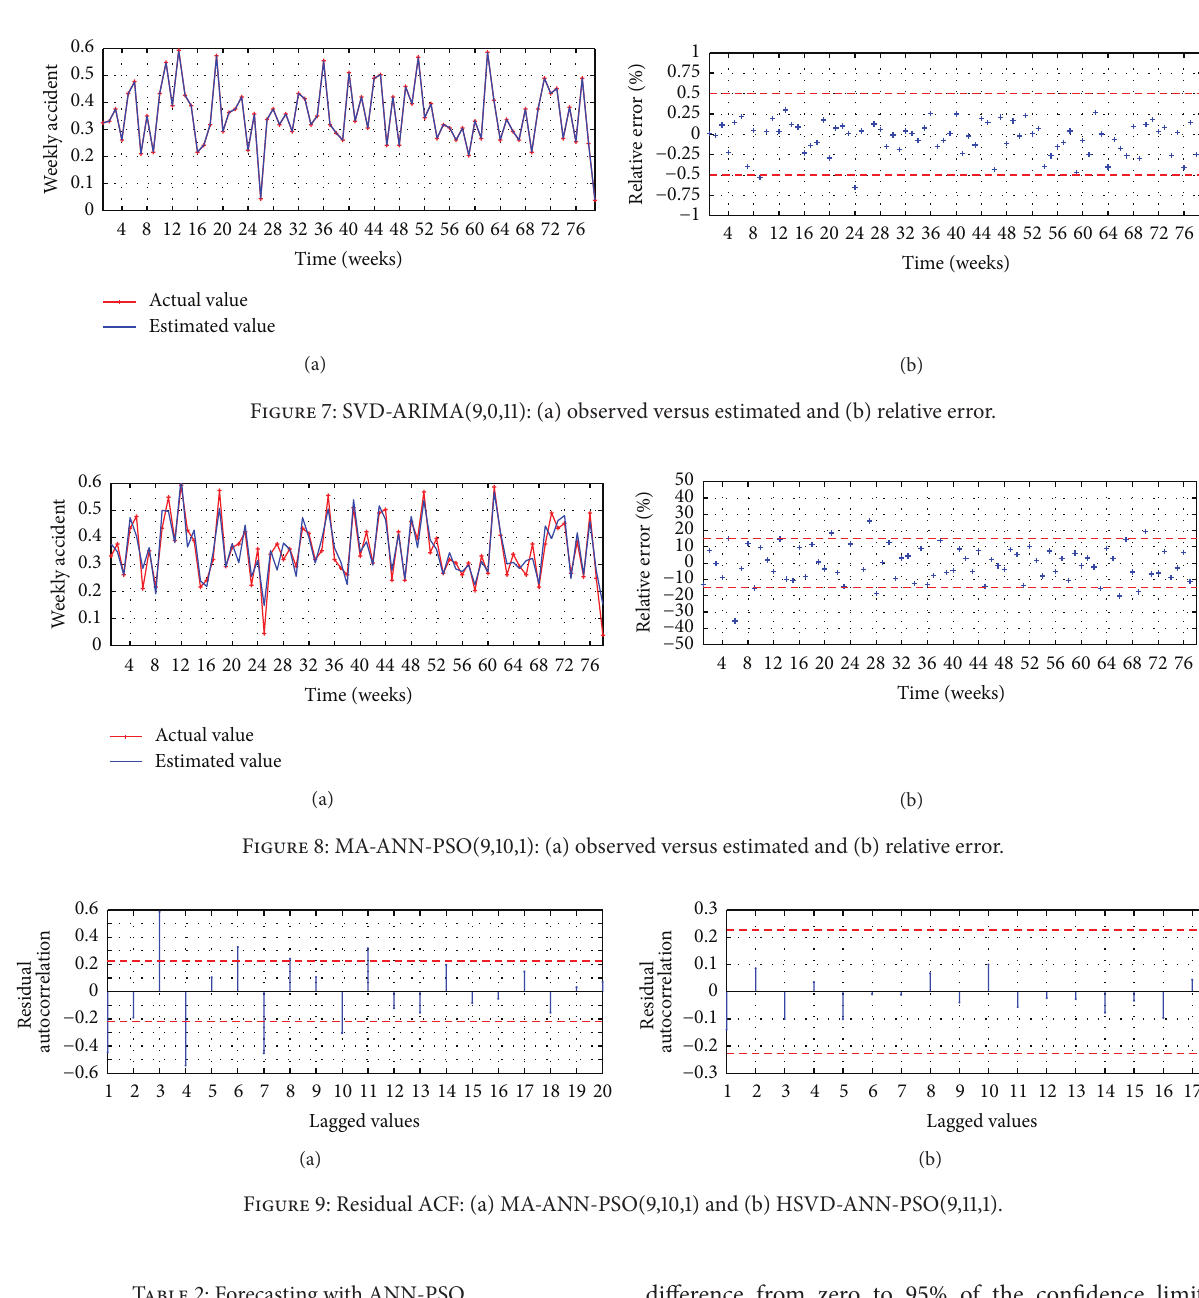
Table 2: Forecasting with